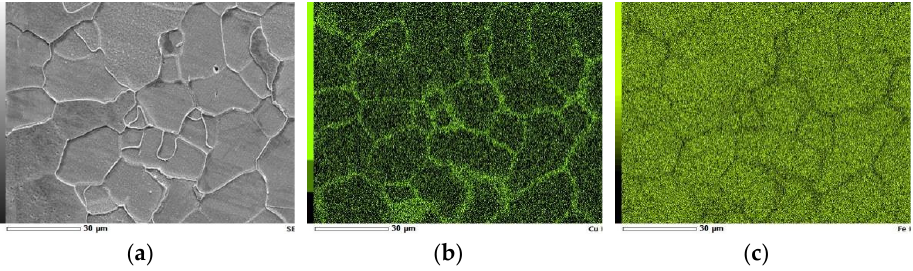
Figure 5. Area scan results of the transition layer of steel side. ( a ) scan area, ( b ) distribution of Cu, and ( c ) distribution of Fe.